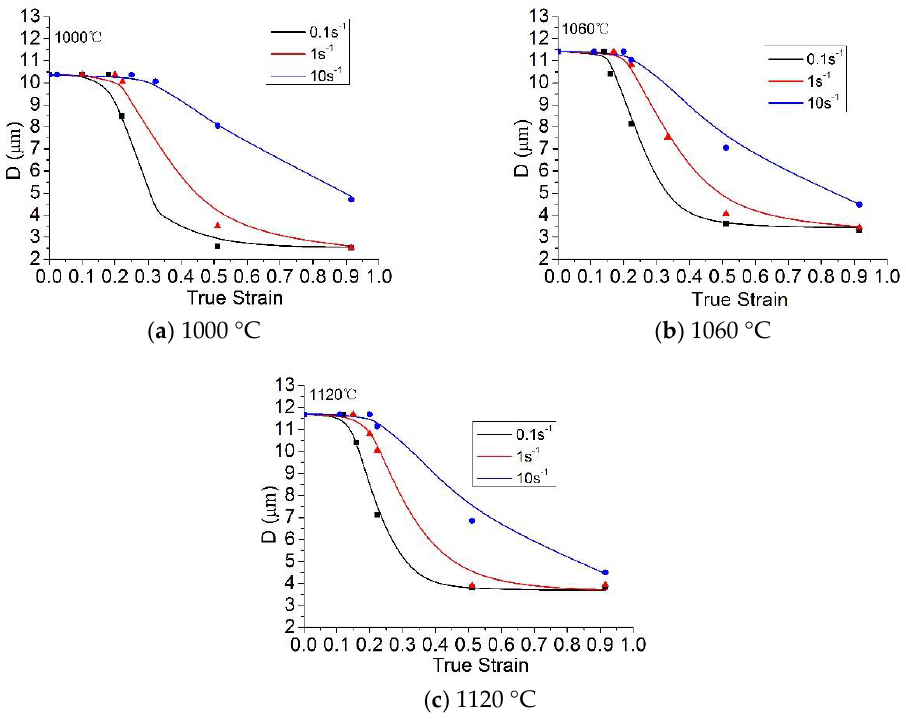
Figure 10. Average grain size prediction (solid lines) and experimental (points) values. Reproduced with permission from [24]. Copyright Elsevier, 2017.